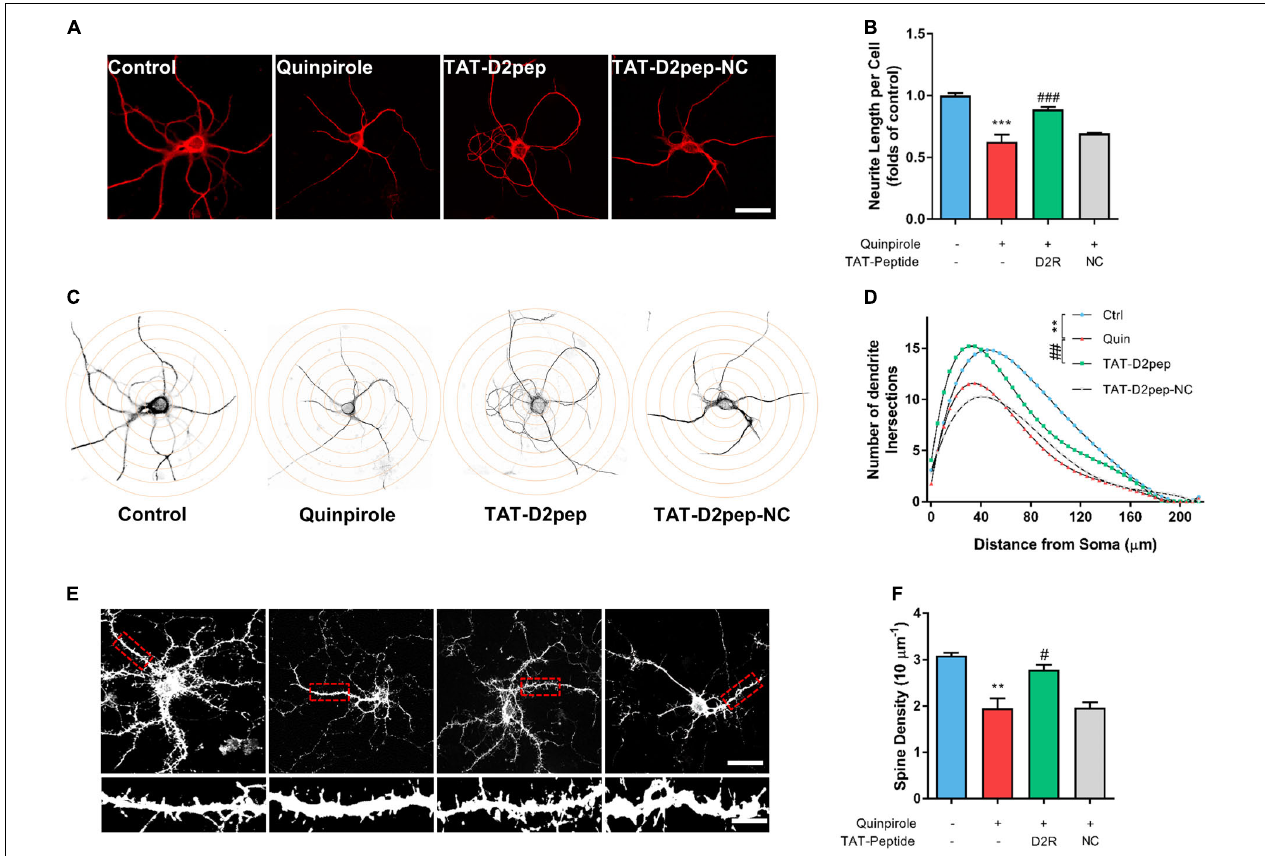
FIGURE 2 | TAT-D2pep protects synaptic spine density and dendritic complexity against D2R hyperactivity in cultured striatal neurons. (A) Representative images of striatal neurons immunostained with MAP-2. Scale bar = 50 µ m. (B) Effect of TAT-D2pep on neurite length. TAT-D2pep inhibited the decrease in neurite length of striatal neurons. (C,D) Sholl analysis of cultured striatal neurons treated with quinpirole and TAT-D2pep. Representative images of striatal neurons with superimposed circles at given distances from the center of the soma. For Sholl analysis, the total number of neurite crossings was counted at each circle with the radius increasing in steps of 5 µ m. ** P < 0.01 versus control; ## P < 0.01 versus quinpirole. (E) Representative images with high magnification of dendrites immunostained with phalloidin-actin Scale bar = 50 µ m (top panels) and 10 µ m (bottom panels). (F) quantification of spine density. ** P < 0.01 and *** P < 0.001 versus control, # P < 0.05 and ### P < 0.001 versus quinpirole by one-way analysis of variance (ANOVA) with post hoc Tukey